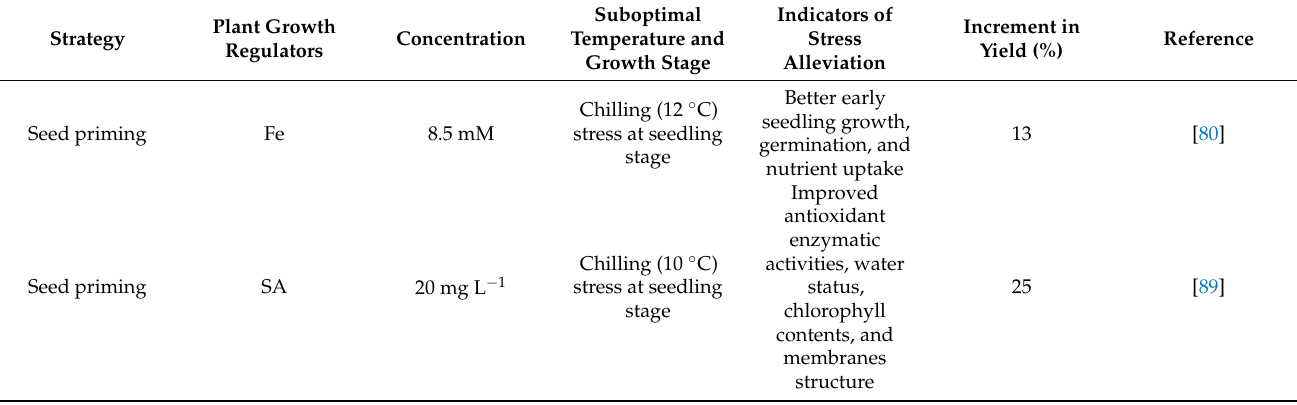
Table 3. Use of plant growth regulators to minimize the impacts of heat and cold stresses at critical phases of maize crop.